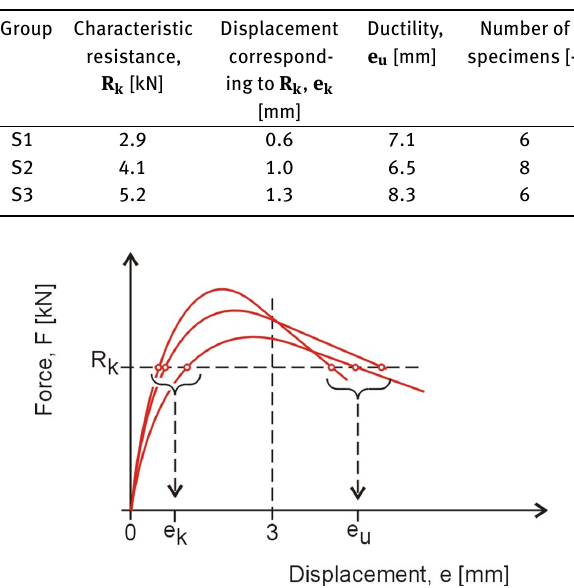
Figure 4: Monotonic load-deformation response of the S2 group (with 1,25 mm thick steel sheets). Table 2: Structural properties of self-drilling screws from statistical evaluation of test results.